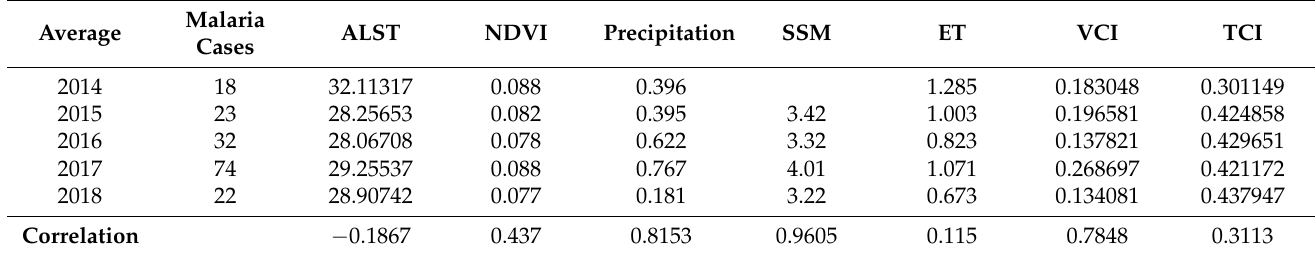
Table 9. Correlation between effective environmental factors and malaria